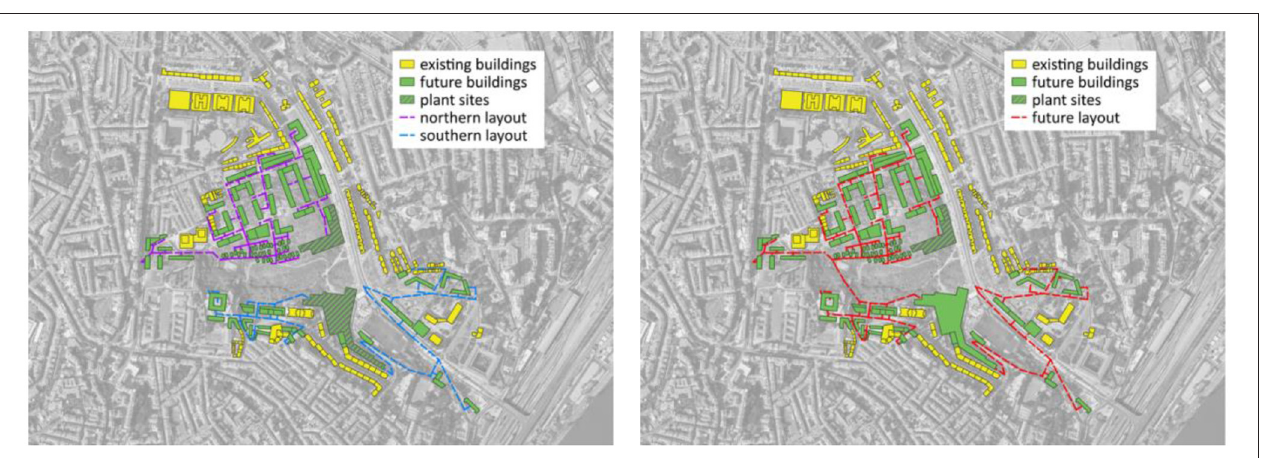
FIGURE 7 | Northern, southern and future